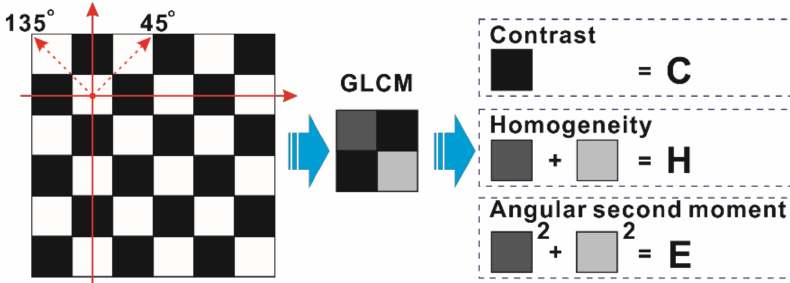
Figure 2. The schematic of three defect-free fiber texture feature extractions. Table 1. The co-occurrence matrices of two conditions